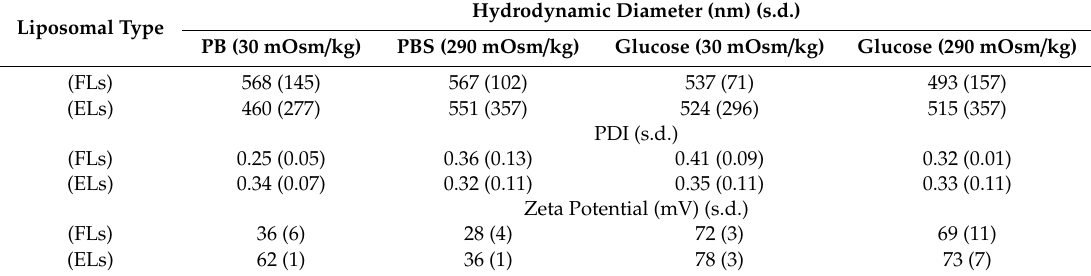
Table 3. Ionic concentration dependence of the hydrodynamic diameter, polydispersity index (PDI) and zeta potential of fusogenic (DOPE / DOTAP / TFPE-head 1 / 1 / 0.1 mol / mol) (FLs) and endocytic (DOPC / DOTAP / TFPE-head 1 / 1 / 0.1 mol / mol) (ELs) liposomes. Experiments are performed in a PBS bu ff er at physiological pH 7.4. Given are averages over three independent measurements and, in parentheses, their standard deviations. Hydrodynamic Diameter (nm) Liposomal Type